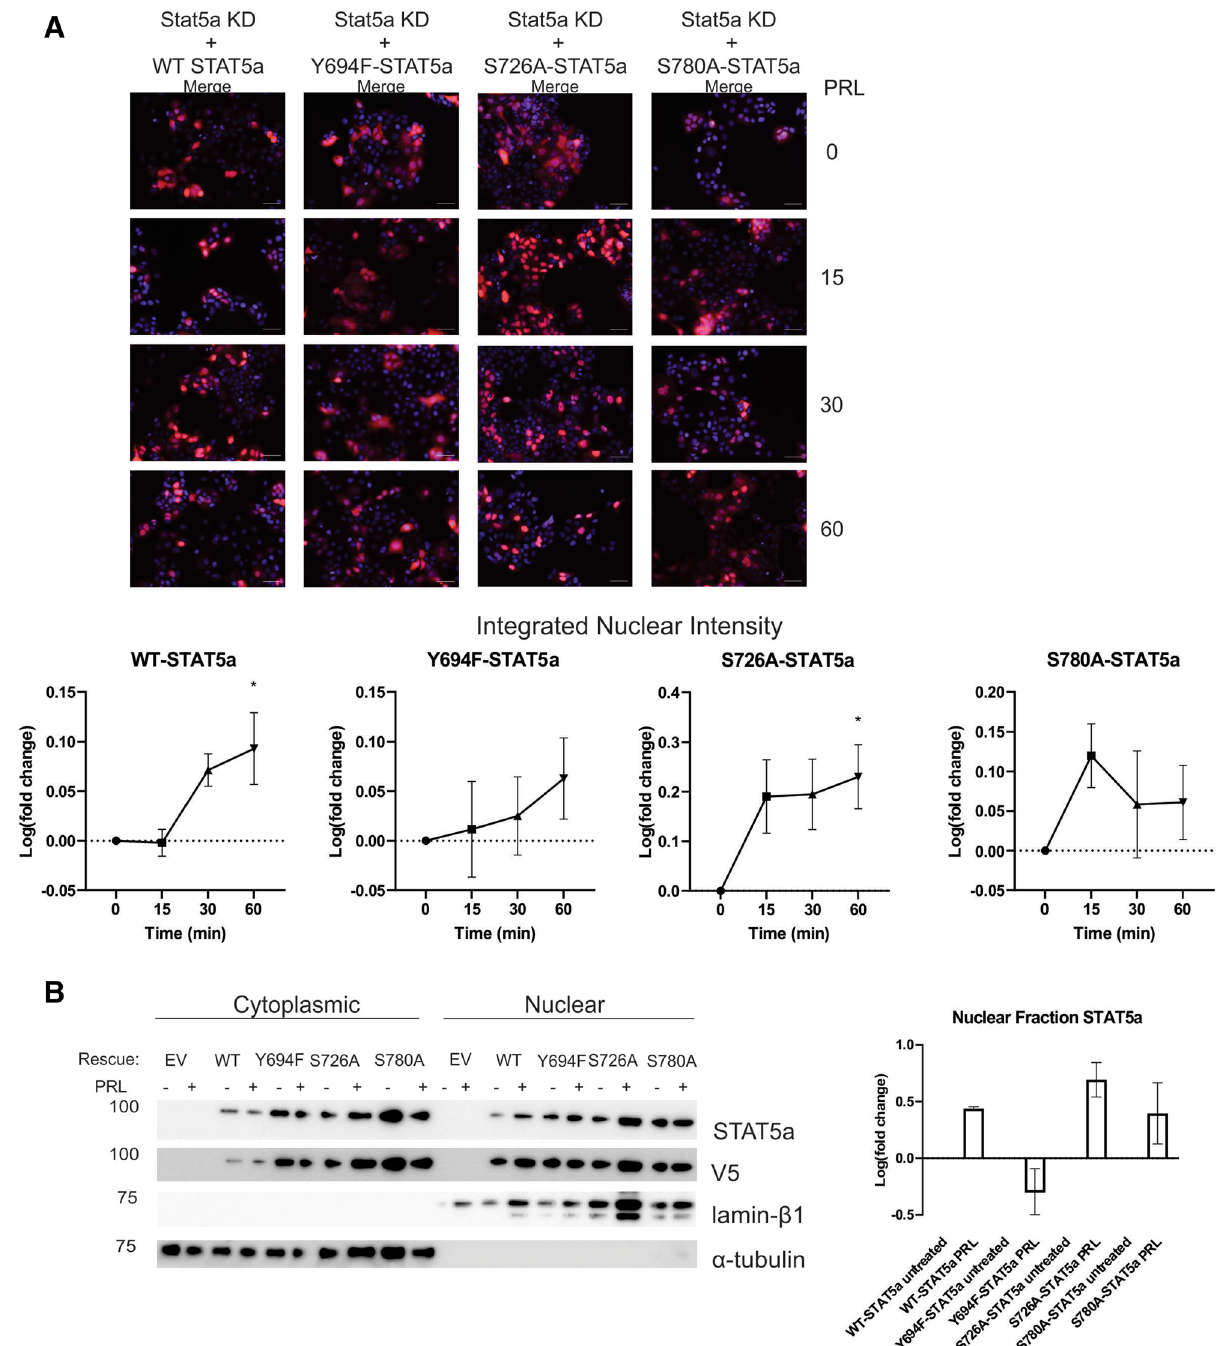
Figure 6. Nuclear translocation of STAT5a occurs in absence of pS726 and/or pS780. MCF7 cells with stable re-expression of STAT5a carrying specific phospho-deficient point mutations were imaged with immunofluorescence with up to 60 min PRL stimulation, representative merged Hoechst and STAT5a images shown, and quantified for nuclear translocation ( A ) or analyzed by WB nuclear cytoplasmic fractionation after 15 min PRL stimulation ( B ). * p < 0.04 compared to untreated, time 0. Graphs and statistics generated in GraphPad Prism 9.0.0 for Windows (GraphPad Software, San Diego, California USA, www. graph pad.